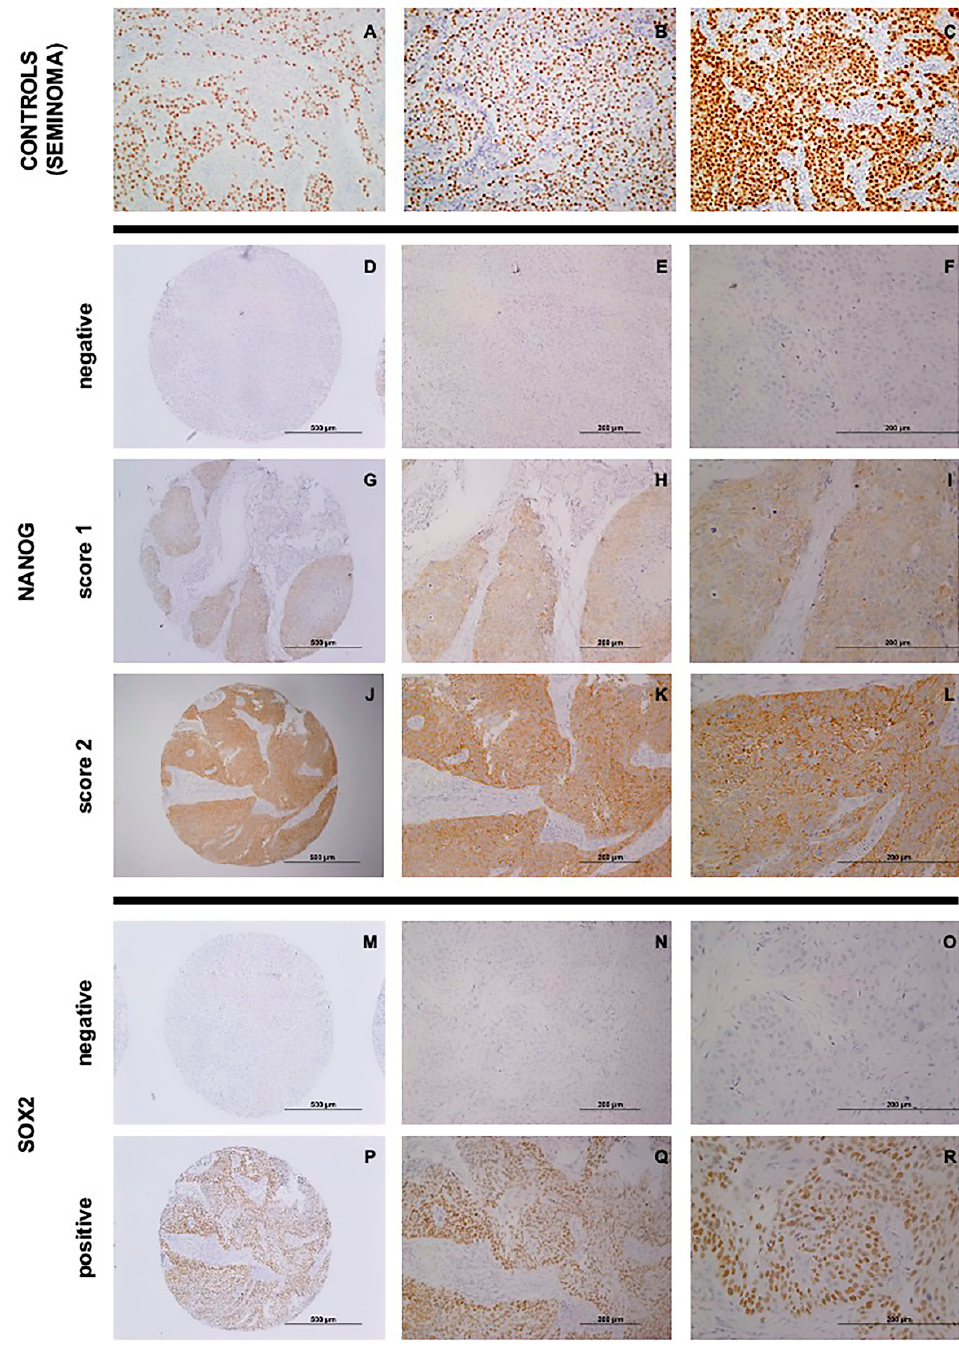
Figure 1. Immunohistochemical analysis of NANOG, SOX2, and OCT4 expression in head and neck squamous cell carcinoma (HNSCC). ( A – C ) Positive controls of human seminoma samples for NANOG ( A ), SOX2 ( B ), and OCT4 ( C ) expression. Representative examples of HNSCC showing negative NANOG staining, score 0 ( D 100 × , E 200 × , F 400 × ); cytoplasmic NANOG staining, score 1 ( G 100 × , H 200 × , I 400 × ); and cytoplasmic NANOG staining, score 2 ( J 100 × , K 200 × , L 400 × ). HNSCC samples showing negative nuclear SOX2 staining ( M 100 × , N 200 × , O 400 × ), and positive nuclear SOX2 staining ( P 100 × Q 200 × , R 400 × ).